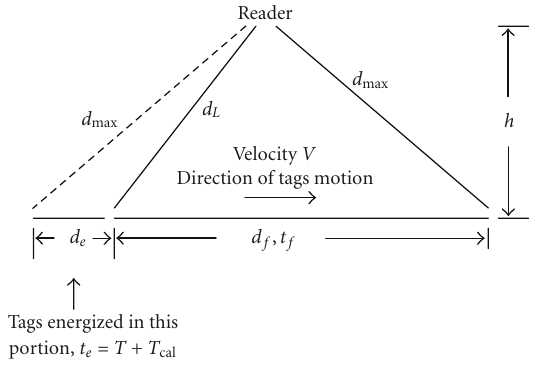
Figure 3: m -ASAP system